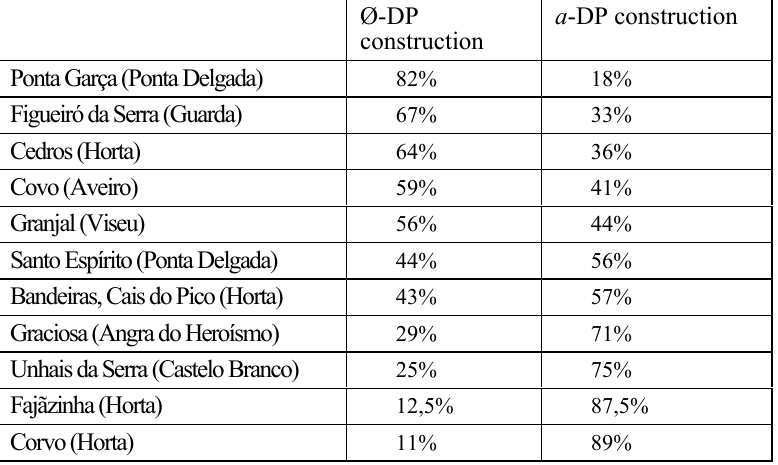
Table I. a /Ø-DP naming constructions in CORDIAL-SIN – relative frequency